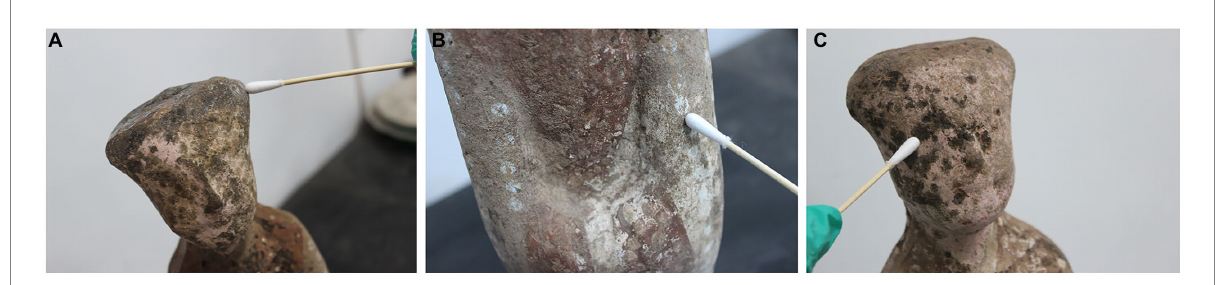
FIGURE 1 Spots on the surface of pottery figurines. (A) Ear of pottery figurine TN61E65M47:3. (B) Left arm of pottery figurine TN61E65M47:3. (C) Face of pottery figurine TN61E65M47: